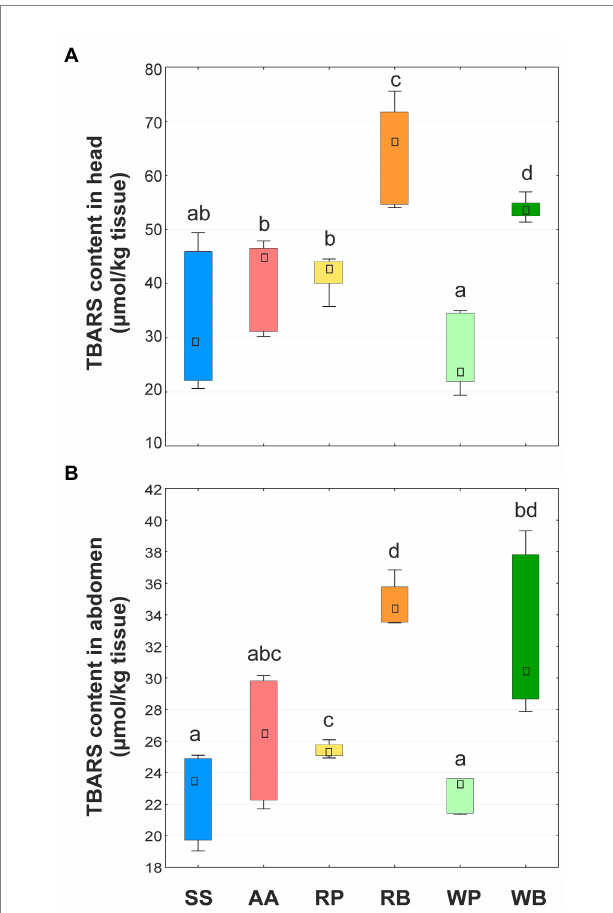
FIGURE 3 Content of thiobarbituric acid reactive substances (TBARS, μ mol/kg tissue) in heads (A) and abdomens (B) of worker bees consuming different diets. SS, sucrose solution (control group); AA, sucrose solution + amino acids; RP, sucrose solution + rapeseed pollen; RB, sucrose solution + rapeseed beebread; WP, sucrose solution + willow pollen; and WB, sucrose solution + willow beebread. Boxes show first and third interquartile ranges with the dot denoting median. Different letters indicate significant differences between the values ( p <